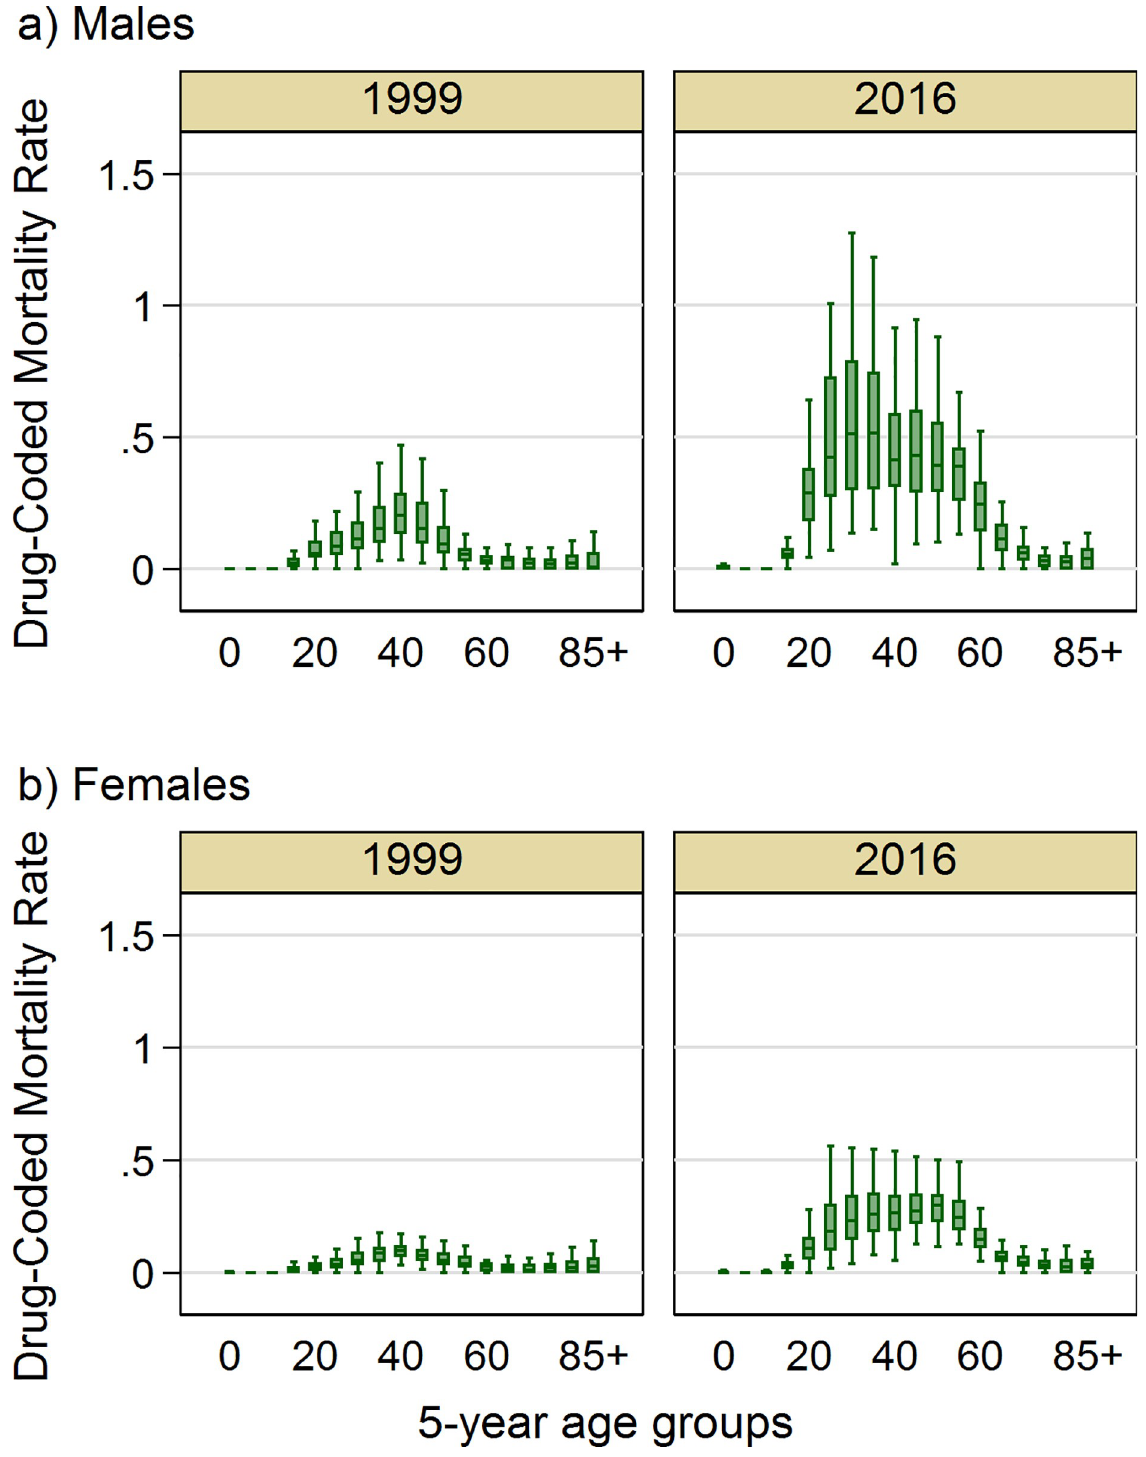
Fig 1. Box plot of drug-coded mortality rate (per 1,000) among 50 US states, by five-year age group in 1999 and 2016 among A) males and B) females. Note: In these plots, the box represents the 25th (p25), 50th (p50), and 75th (p75) percentiles of the distribution; the whiskers represent the lower and upper adjacent values. The lower adjacent value is defined as p25 − 1.5 × IQR,where IQR = p75 − p25. Similarly, the upper adjacent value is defined as p75+1.5 × IQR. Values outside of the whiskers are not shown.